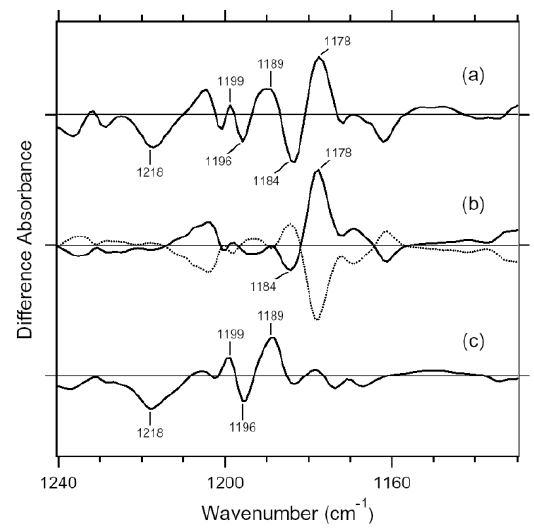
Figure 15. Difference FTIR spectra in the 1,240–1,130 cm -1 region measured at 77 K (in H O), where the spectra before illumination were subtracted from those after 2 illumination. Light-adapted ASR that contains 13C-ASR (78%) and AT-ASR (22%) was first illuminated with 501 nm light for 1 min (a). Then, illumination at >560 nm for 1 min converted a part of the photoproducts in (a) to the original state (dotted line in b). Subsequent illumination with 501 nm light yields the difference spectrum (solid line in b), which is a mirror image of the dotted spectrum. Repeated illuminations at >560 nm and at 501 nm yield the identical spectra. (c) The AT-ASR minus AT-ASR spectra are K reproduced from Furutani et al . [20]. This figure is reprinted with permission from Kawanabe et al. [59]. Copyright 2006 American Chemical